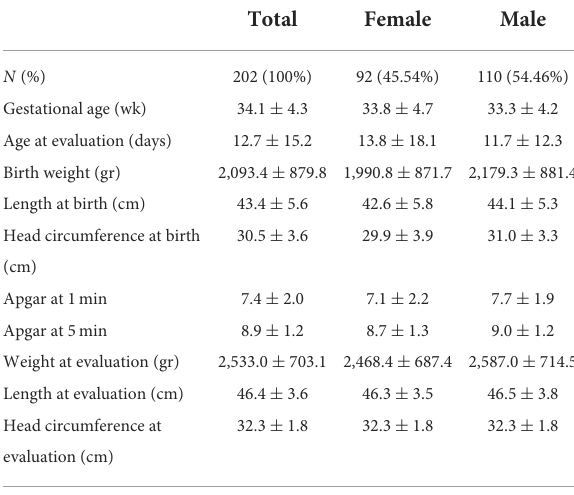
TABLE 3 General characteristics of the sample